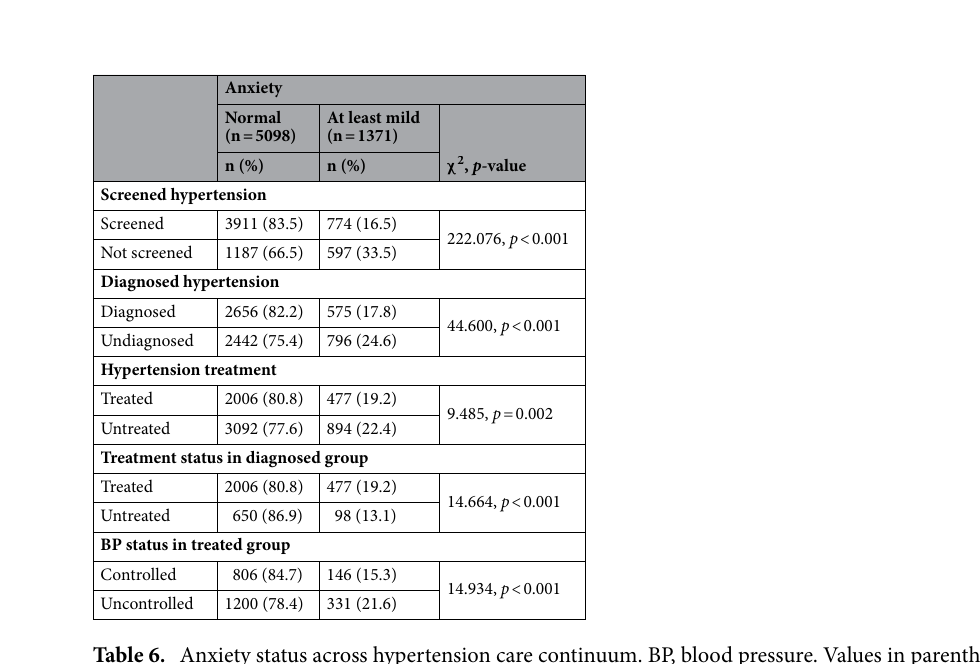
Table 5. Depression status across hypertension care continuum. BP, blood pressure. Values in parentheses are the percentage of the cases.